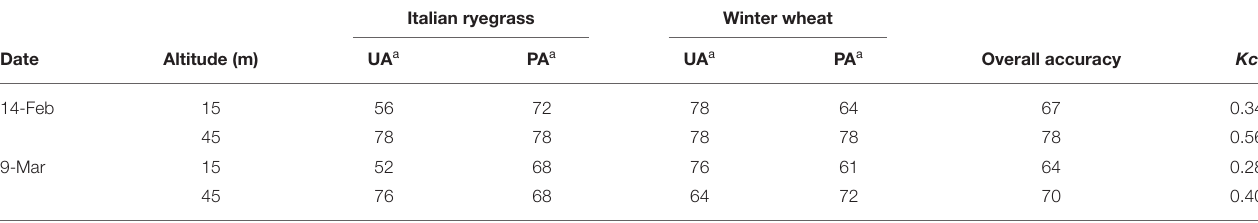
TABLE 1 | Summary of the 2-class supervised classification of discriminating between Italian ryegrass and winter wheat at different dates.